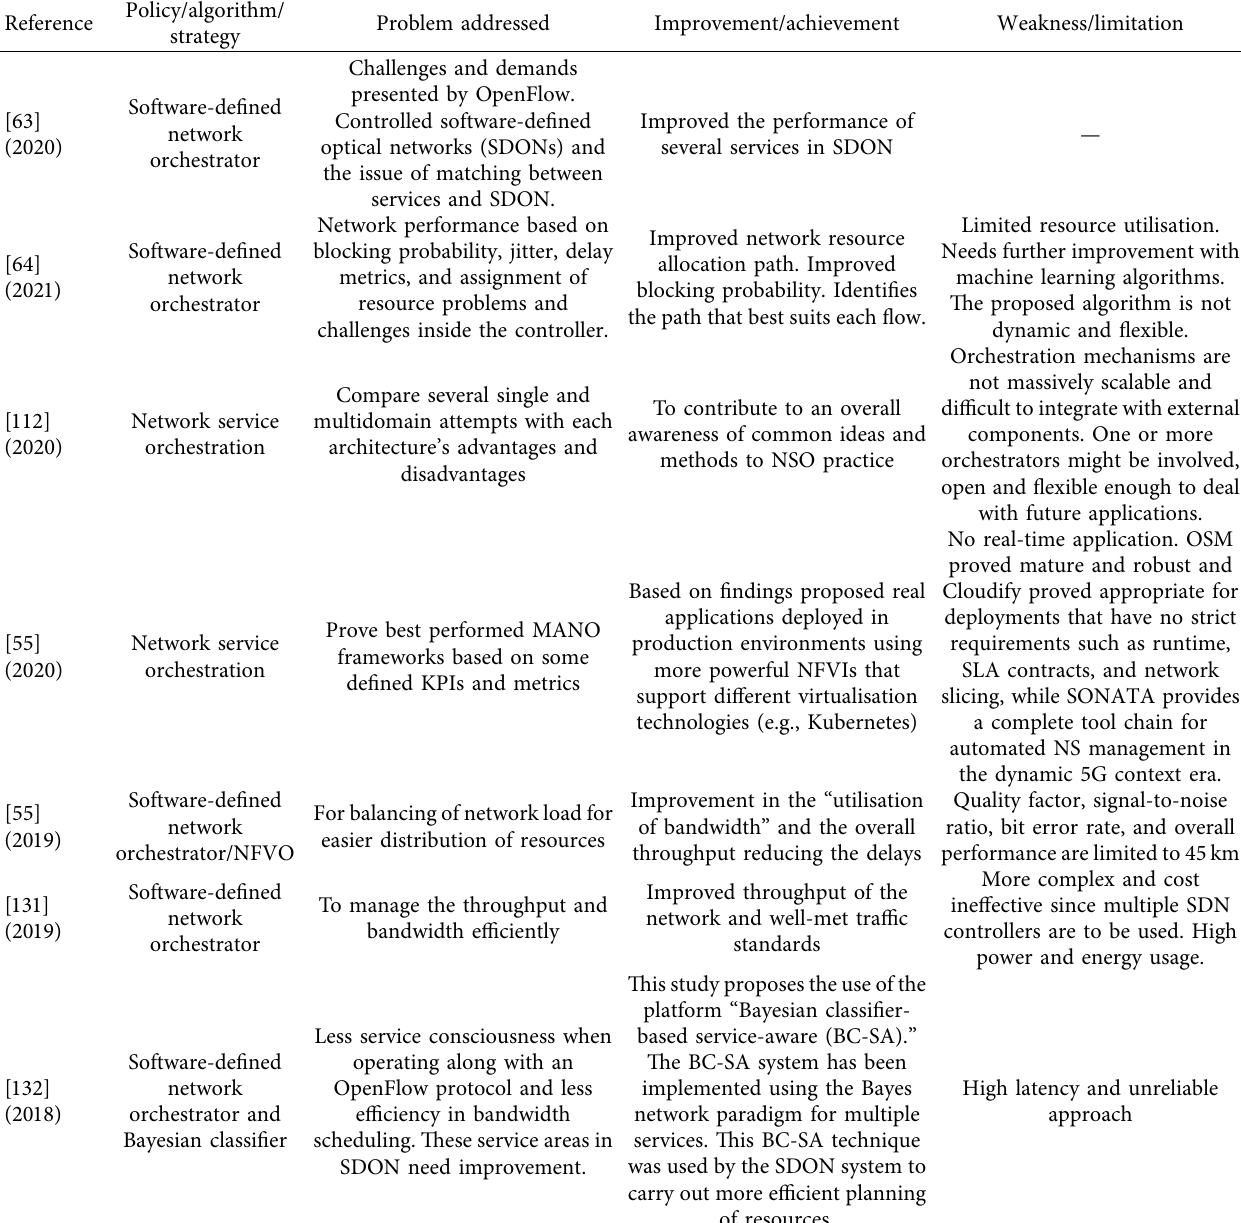
Table 12: Summary of SDN orchestration solutions and